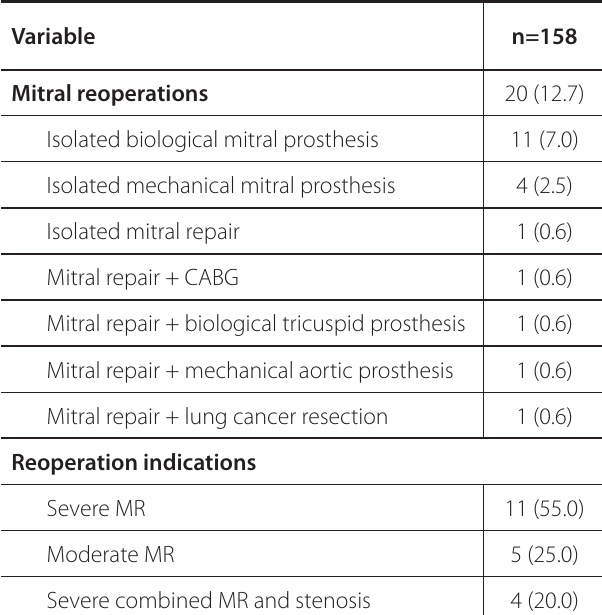
Table 4 . Mitral reoperations during follow-up and